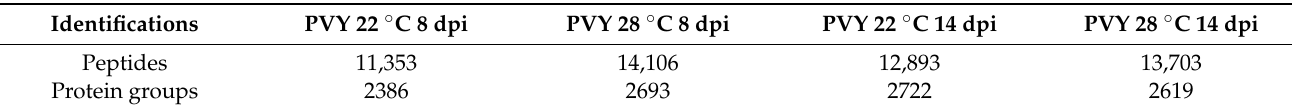
Table 1. Numbers of peptides and corresponding protein groups identified by liquid chromatography with mass spectrom- etry (LC–MS/MS).